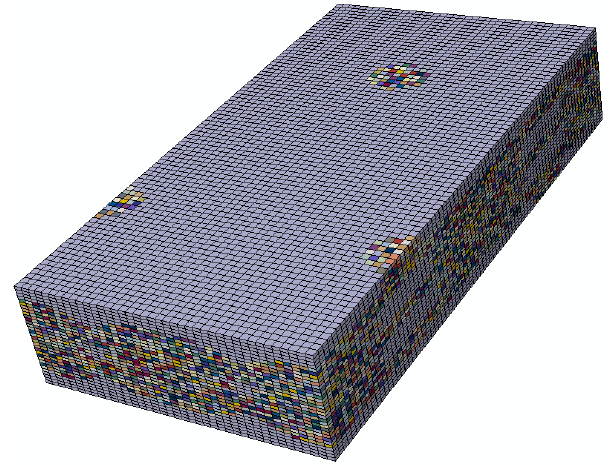
Figure 13. Representative volume element of mesoscale model with random material properties